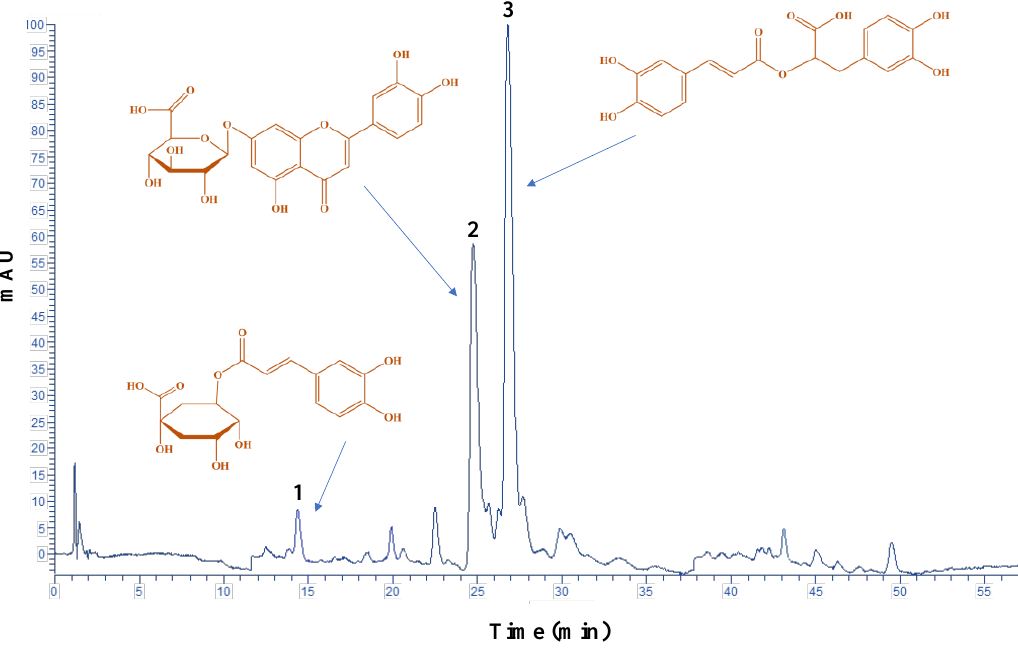
Figure 8. Chromatographic analysis of polyphenols in a S. fruticosa extract, produced under optimized conditions (S S = 900 rpm, C DES = 77% ( w / v ), and t US = 15 min). The chromatogram was obtained at 330 nm. Peak assignment: 1, chlorogenic acid; 2, luteolin 7- O -glucuronide; 3, rosmarinic acid. Table 5. Extraction yield in principal polyphenolic phytochemicals of S. fruticose , using LA-SCDB15, methyl β-cyclodextrin (m-β-CD) and 60% ( w / v ) glycerol/water (GL). Values reported are means ± standard deviation.